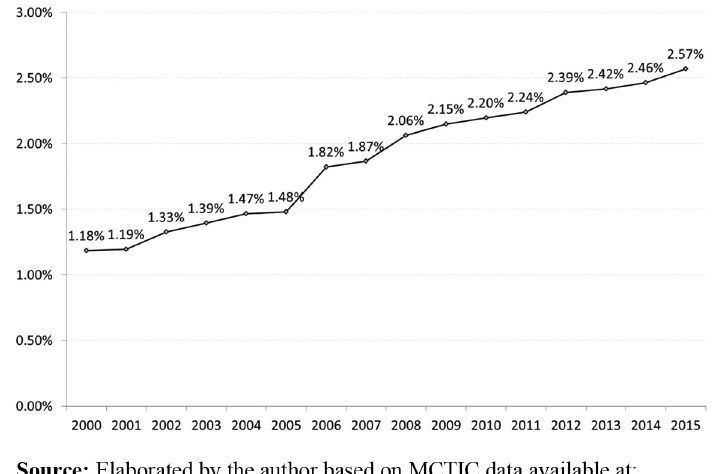
Figure 2. Brazilian share in the